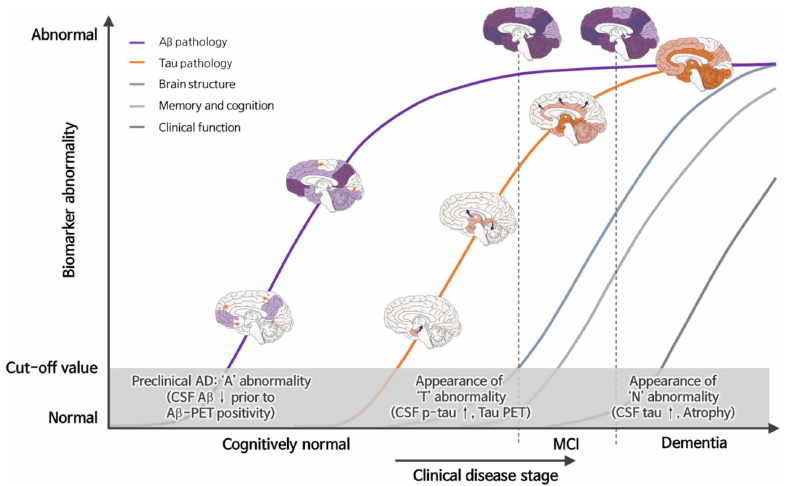
Figure 1. Biomarkers and changes in spatiotemporal pattern of Aβ and NFT deposit during disease cascade. Abnormality in CSF Aβ42 and Aβ-PET (‘A’ abnormality) are biomarkers in pre-clinical stage, followed by abnormality in CSF p-tau or Tau-PET and ‘N’ abnormality (increased CSF T-tau and hippocampal